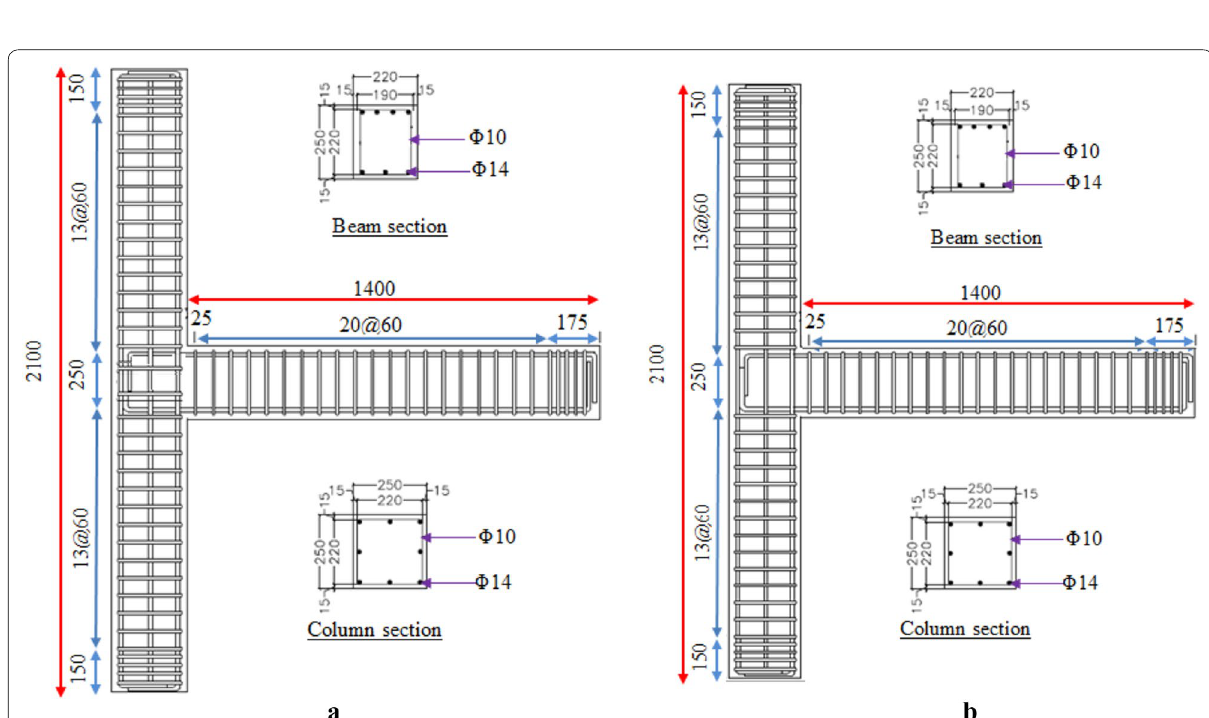
Fig. 8 Size and reinforcement details of beam-column connection specimens: a Specimen J 1 ; b Specimen J 2